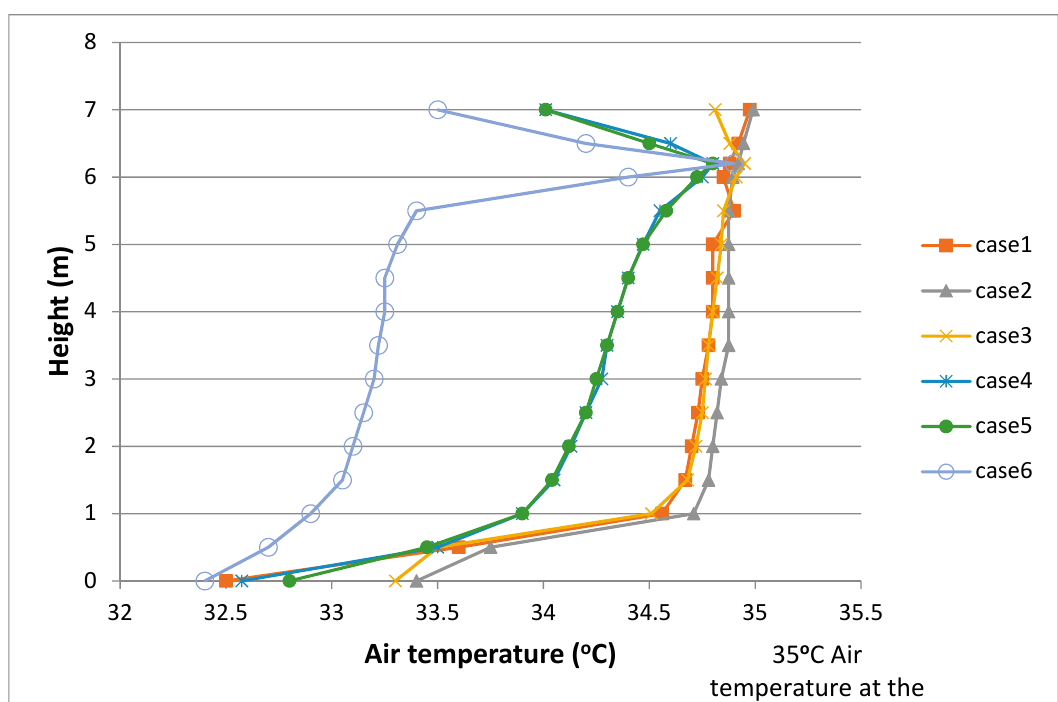
Figure 12. Simulated mean air temperature at the 7 m height vertical line in the alley centre.